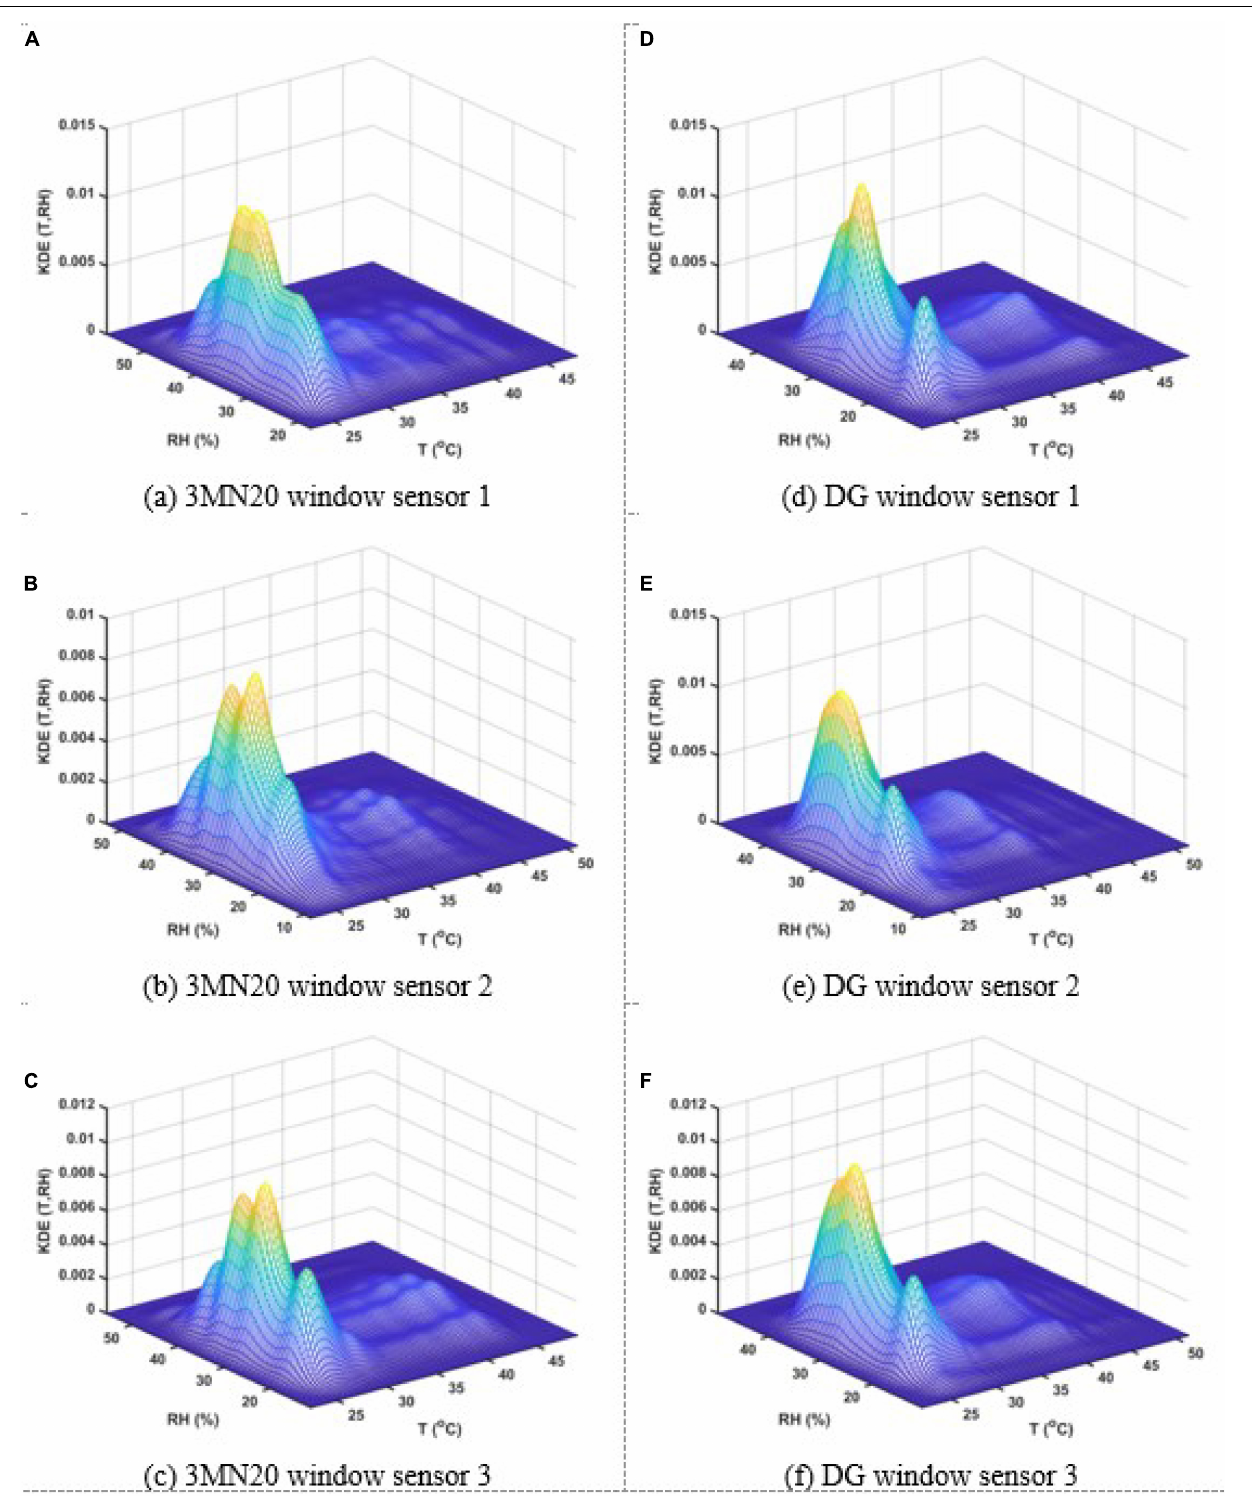
FIGURE 8 | Combined kernel density estimation (KDE) of temperature (T) and relative humidity (RH) for three DHT22 sensors on the interior glass surface of windows during the month of June 2019; (A–C) 3MN20 windows, and (D–F) DG windows.